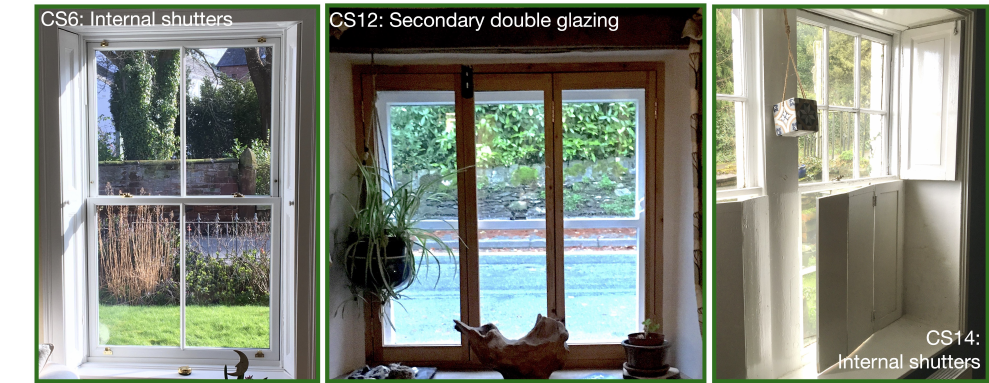
Figure 2. Internal shutters and secondary glazing in different cases.